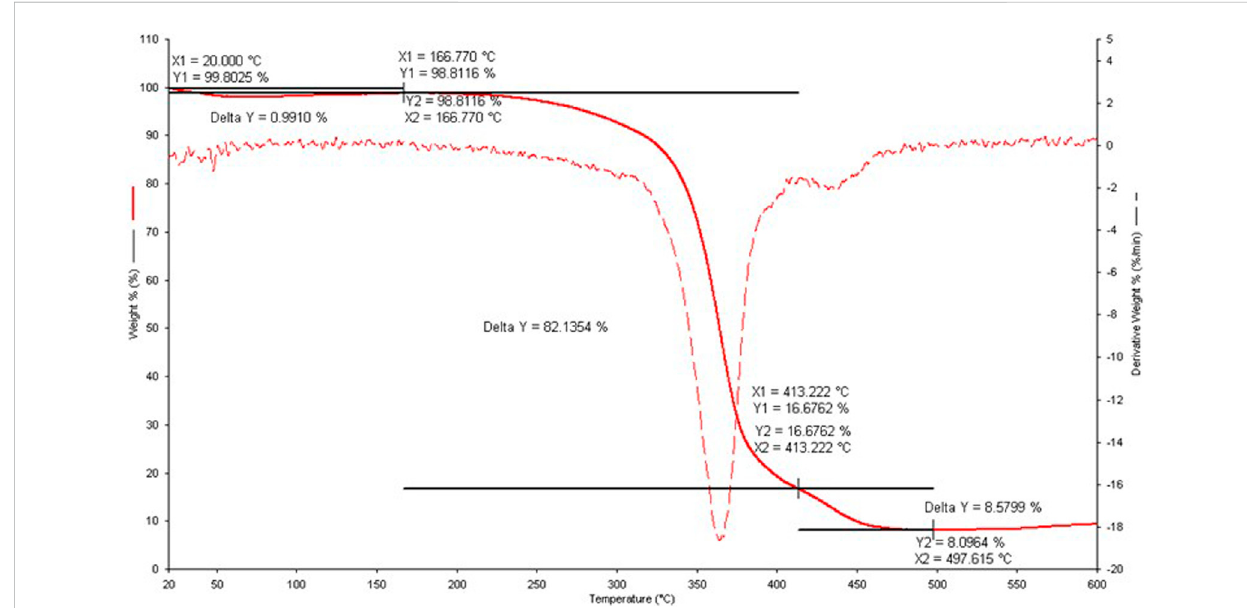
FIGURE 4 Thermogravimetric curve for the Cu 2+ / Eph − solid sample obtained at I = 0.156 mol dm − 3 , c Cu2+ = 1.0 mmol dm − 3 and c Eph- = 4.0 mmol dm − 3 . Solid line: % weight loss as function of t/ ° C, dash line: derivative weight loss vs. t/ ° C.